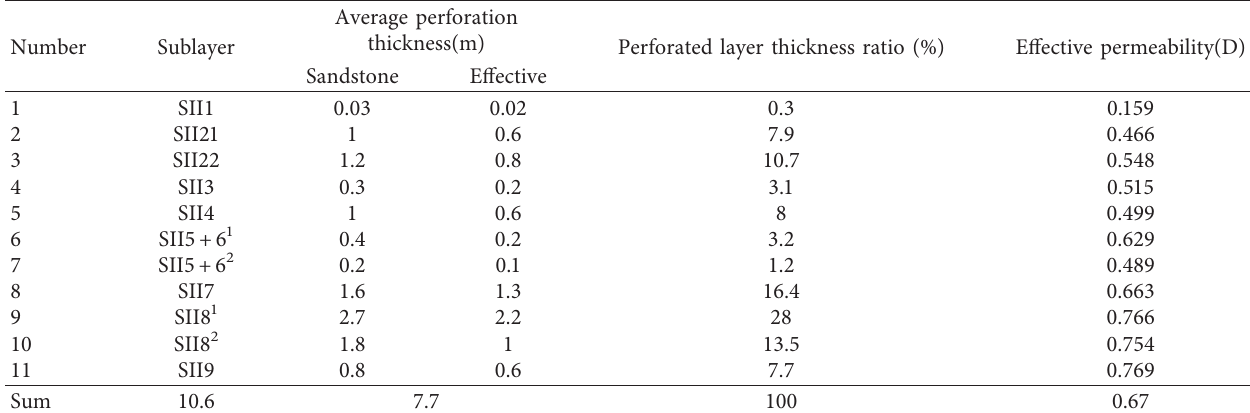
Table 8: SASP perforated layer thickness and permeability distribution [72].